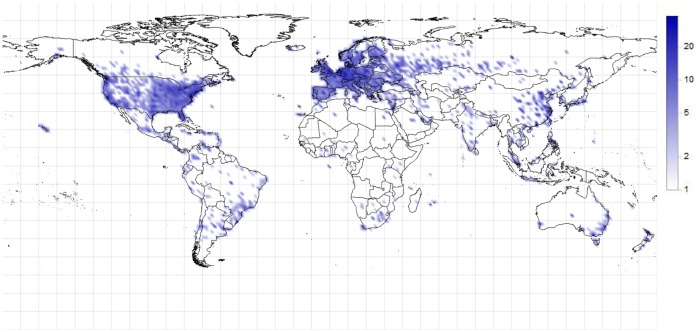
Distribution of the identified Bitcoin clients (1/100 km2).